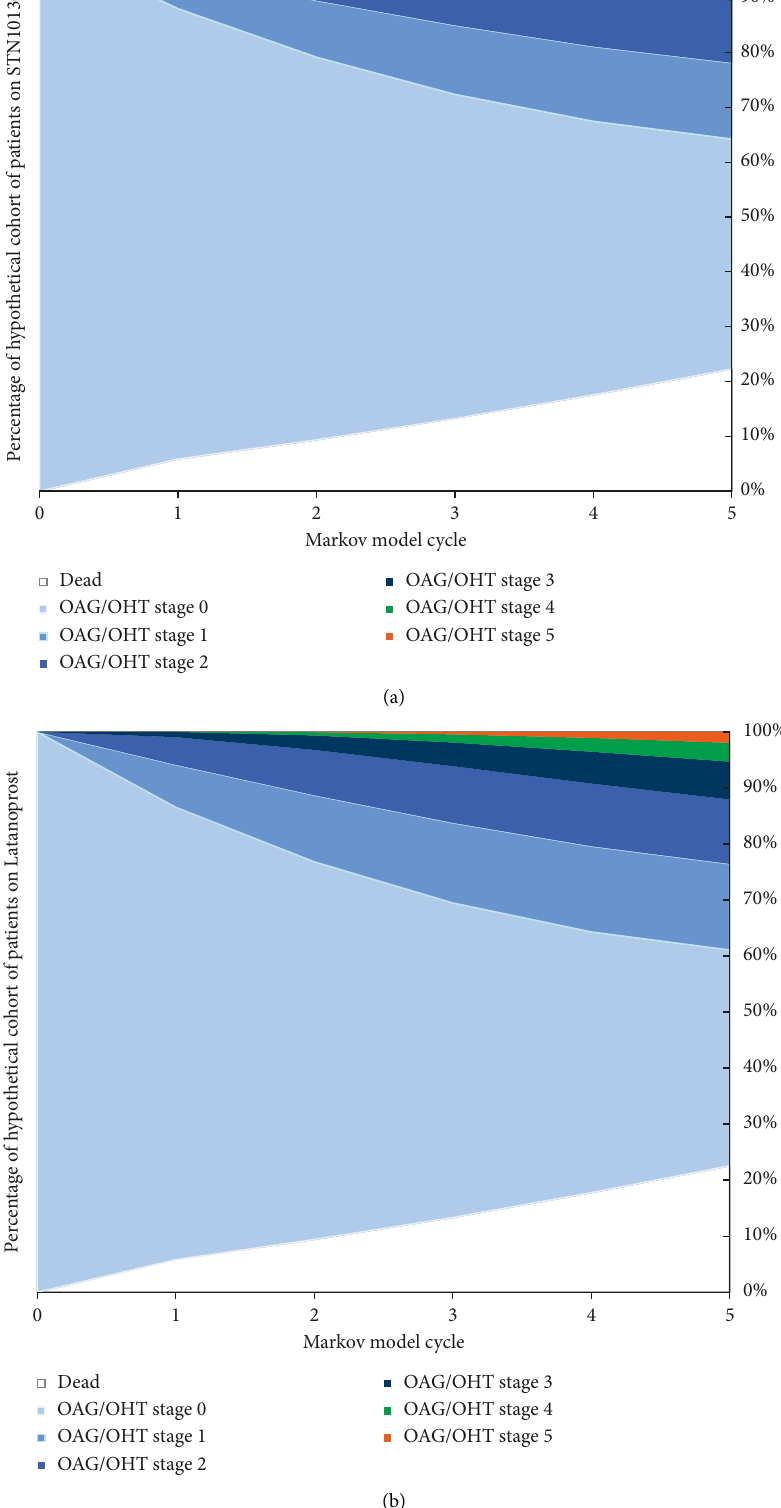
open-angle glaucoma or ocular (cid:31)